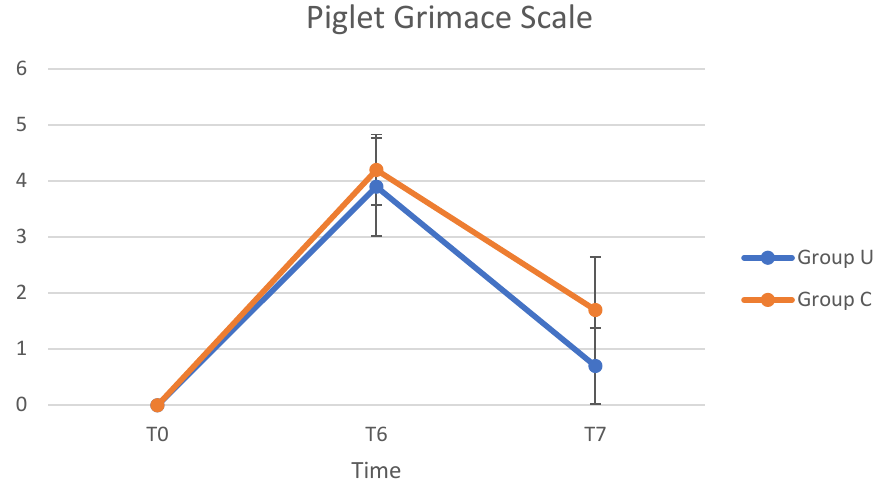
Figure 5. Average values of T ( ◦ C), in Group U (pigs underwent ultrasound examination before cryptorchidectomy) and Group C (control group, without ultrasonography), at times T1 (surgical preparation, after placing the animal on the operating table and inducing anaesthesia), T2 (skin incision), T3 (manipulation of the testicle), T4 (resection of the testis and release of residual stump of the spermatic cord), and T5 (end of surgery, after applying the last simple stitch on the skin). The PGS values varied from T0 to T7 (Figure 6). The maximum PGS value was observed at T6, and after then the score decreased until T7. From the analysis of ANOVA for repeated measures, statistically significant differences were observed in the comparison of the Piglet Grimace Scale between groups ( p = 0.0002), times ( p < 0.0001), and interaction between time and group ( p = 0.035). At T6, all pigs who underwent pain evaluation had a PGS score of >2/5 and were administered an IM injection of ketoprofen. Given the uniformity of PGS values at T6 (>2/5) in the 10 pigs evaluated, analgesia by administration of ketoprofen IM was applied to all animals enrolled for the study 6 h after the end of surgery.